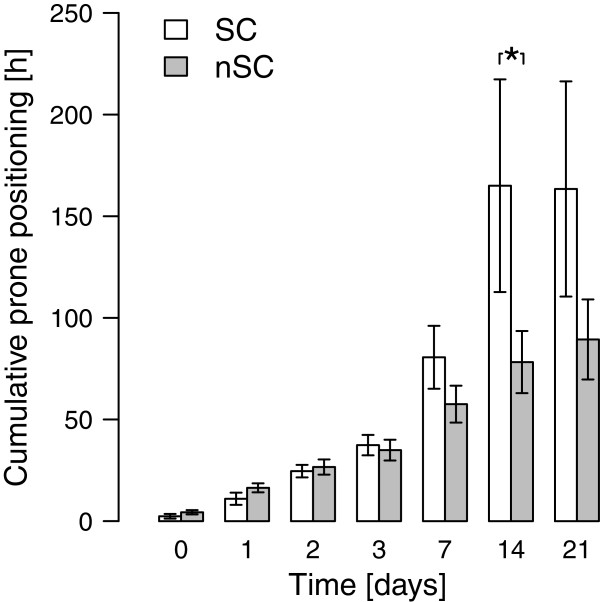
Cumulative time of pronation in patients without (nSSC) and with (SSC) secondary cholangitis. * indicates significant difference (P = 0.04).